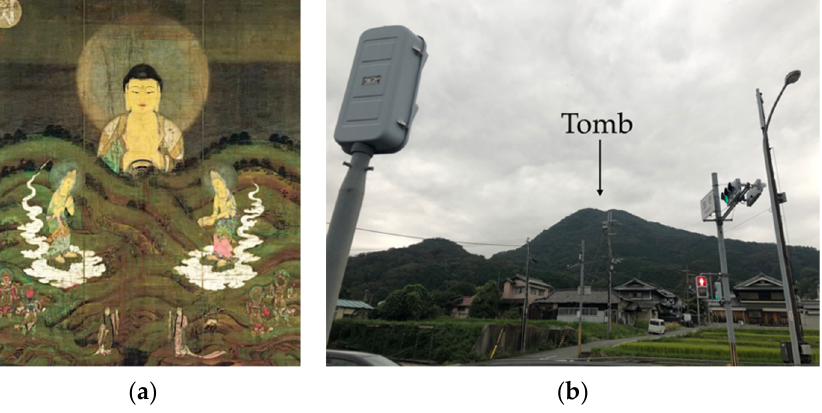
Figure 2. Images of the Japanese ancient mountains: ( a ) Author unknown, “ Descent of Amida (Amit- abha) over the Mountain ”, hanging scroll, color on silk, 138 × 118 cm, 13c, Eikando Zenrin-ji Temple, Kyoto, Japan; ( b ) Mt. Futakami (Nijo), right side peak called Odake (literally, “male top”).